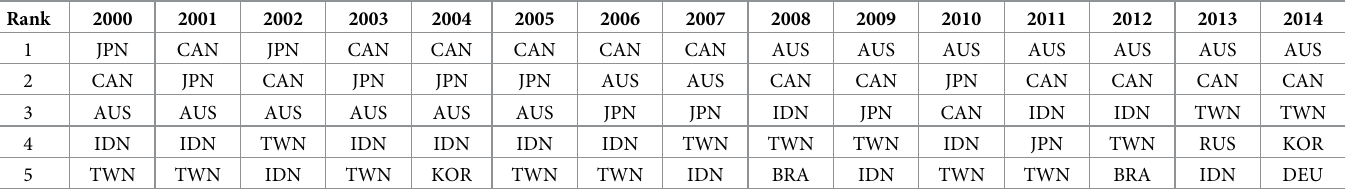
Table 9. Five highest-potential countries in the Pacific Rim community. Rank